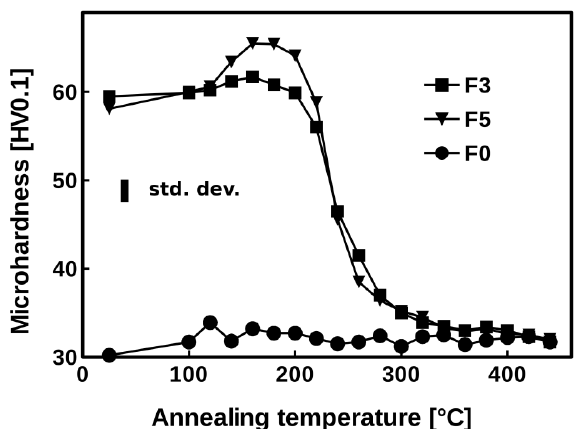
Figure 1. Evolution of microhardness in undeformed (F0) and accumulative roll-bonding (ARB) processed (F3 and F5) specimens during step-by-step